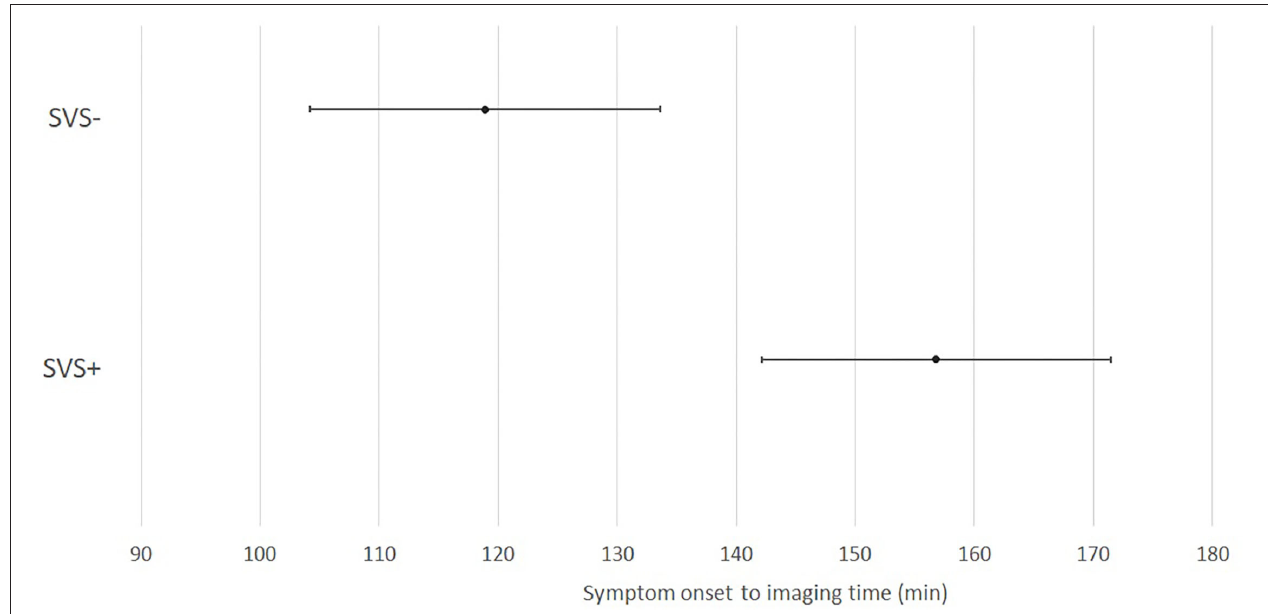
FIGURE 2 | Repartition of susceptibility vessel sign over time from symptom onset to imaging in the KSO subgroup. SVS, susceptibility vessel sign; min, minutes.